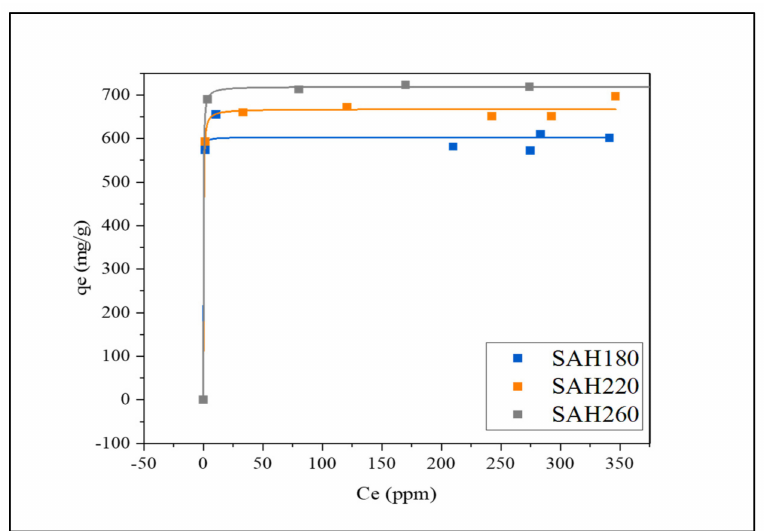
Figure 5. Methylene Blue dye removal by the superactivated hydrochars (SAH180, SAH220,